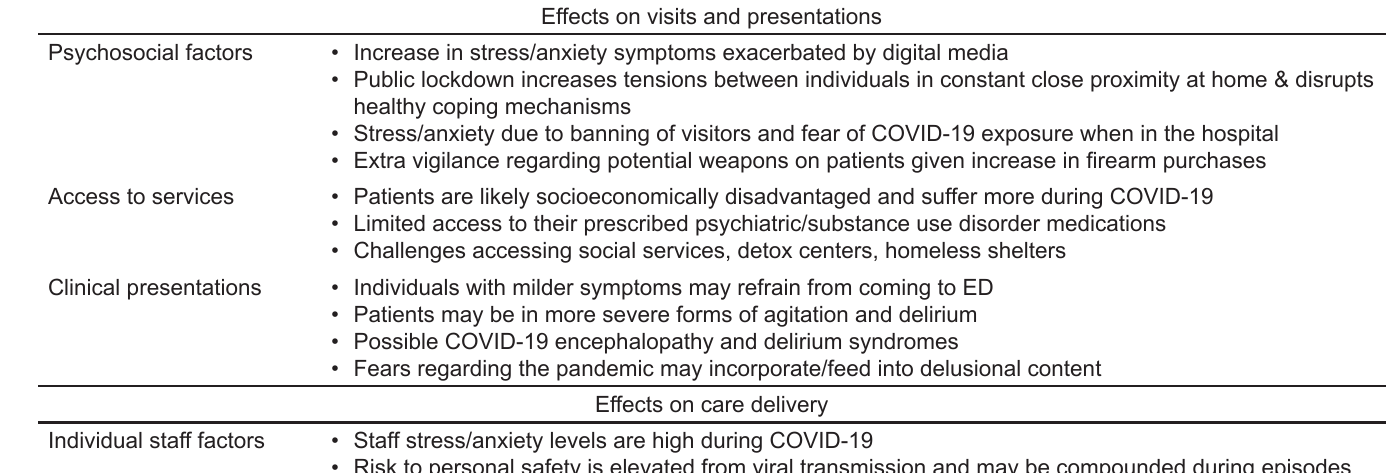
Table 1. Summary of COVID-19